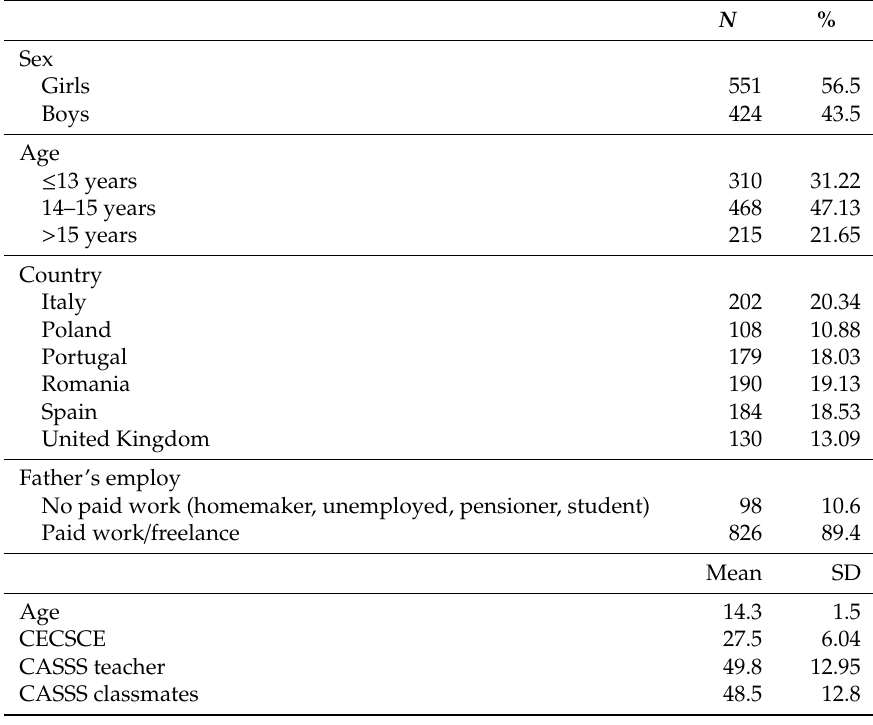
Table 1. Descriptive analysis of the sample ( n =